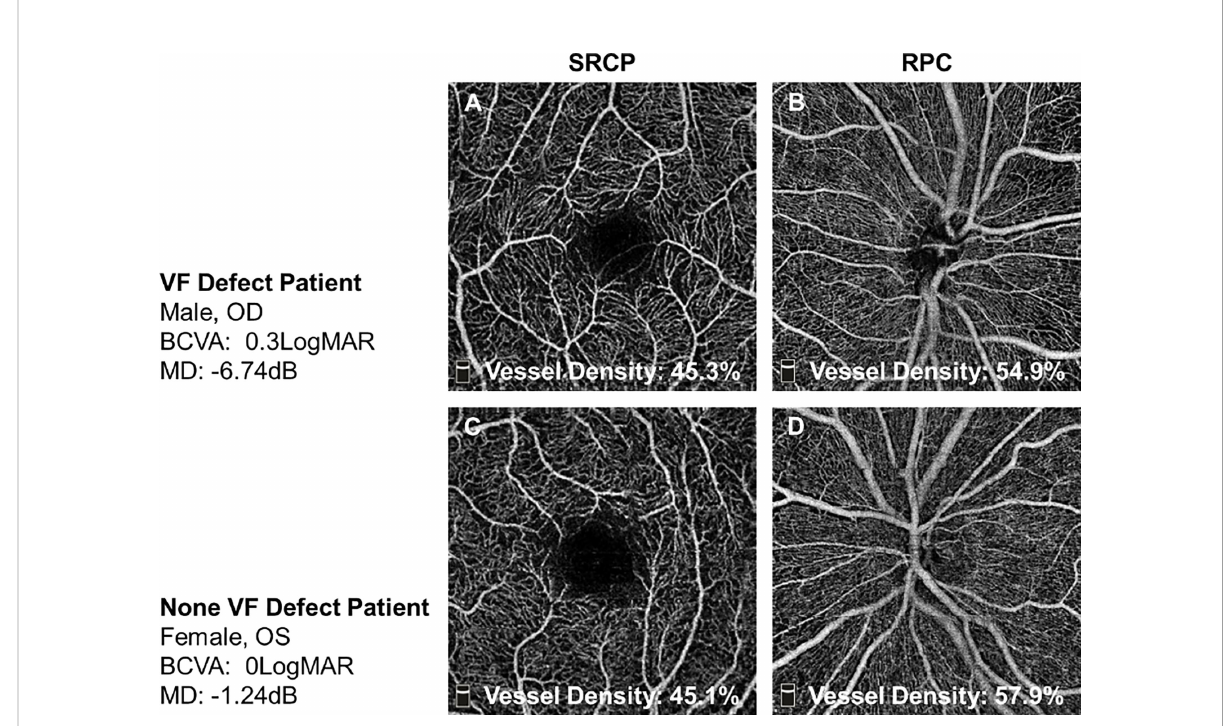
FIGURE 1 The representative OCTA images of TAO patients with or without VF defect. (A, B) In one VF defect TAO patient, his whole SRCP density was 45.3% and whole RPC density was 54.9%. (C, D) In one no-VF defect TAO patient, her whole SRCP density was 45.1% and whole RPC density was 57.9%. SRCP, super fi cial retinal capillary plexus; RPC, radial peripapillary